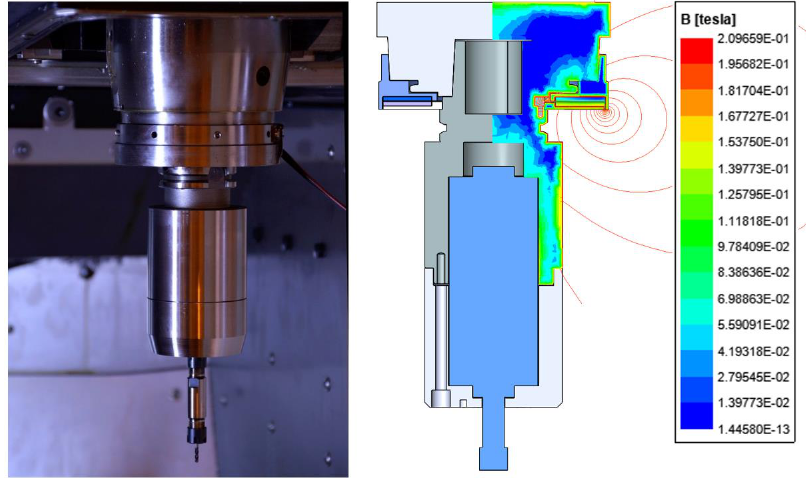
Figure 4. FE model ( right ) of the resulting prototype ( left ).